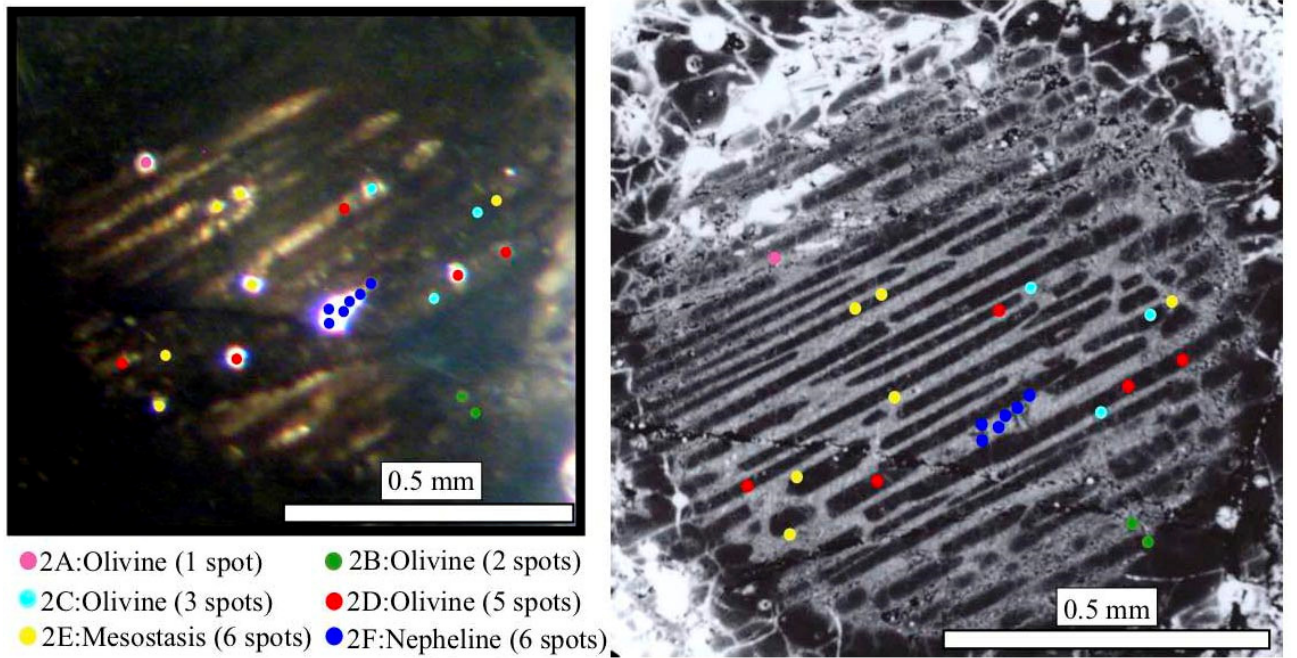
Figure 4. Optical view and its BSE image of BOC-06 showing laser shot locations with different colors. The number of laser spots is one shot for the 2A olivine phase (pink), two shots for the 2B olivine phase (green), three shots for the 2C olivine phase (sky blue), five shots for the 2D olivine phase (red), and six shots for the 2E mesostatic phase (yellow) and 2F nepheline phase (blue).